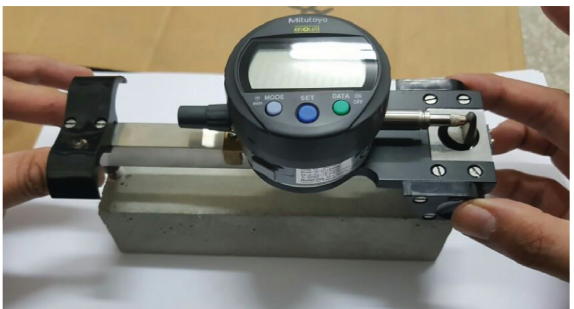
Figure 3: Strain gauge.